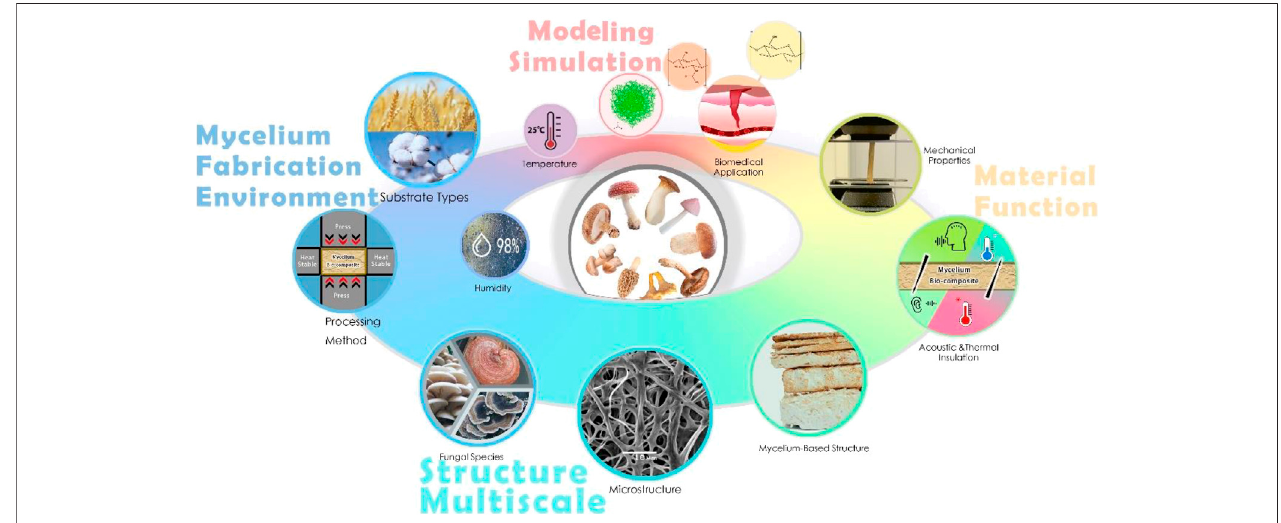
FIGURE 1 | The mycelium study, including its multiscale structure, material function, and how environmental factors de fi ne these characteristics. It is essential to reveal their relationships by using experiments combined with modeling and simulation methods (the fi nite element modeling Islam et al., 2017 and mycelium-based structures Haneef et al., 2017 are reused under a creative commons attribution